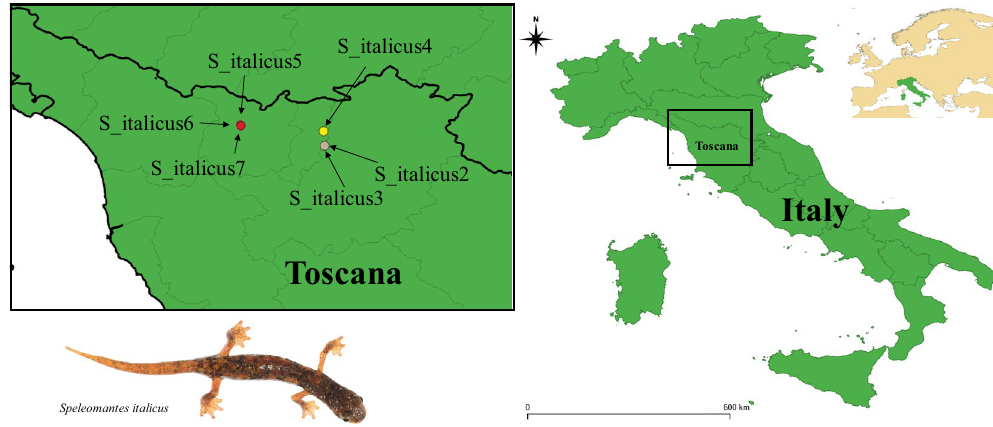
Figure 1. The map of the study area indicating the location of the studied caves. Three caves were located in the municipality of Pistoia (red circles; S_italicus5, S_italicus6, S_italicus7), 1 in the municipality of Vaiano (yellow circle; S_italicus4) and 2 in the municipality of Prato (grey circles; S_italicus2, S_italicus3). No detailed information on sampled locations are provided to ensure species protection 84 . In the bottom-left corner an individual of Speleomantes italicus (the image is taken from the dataset published by Lunghi et al. 83 , as well as